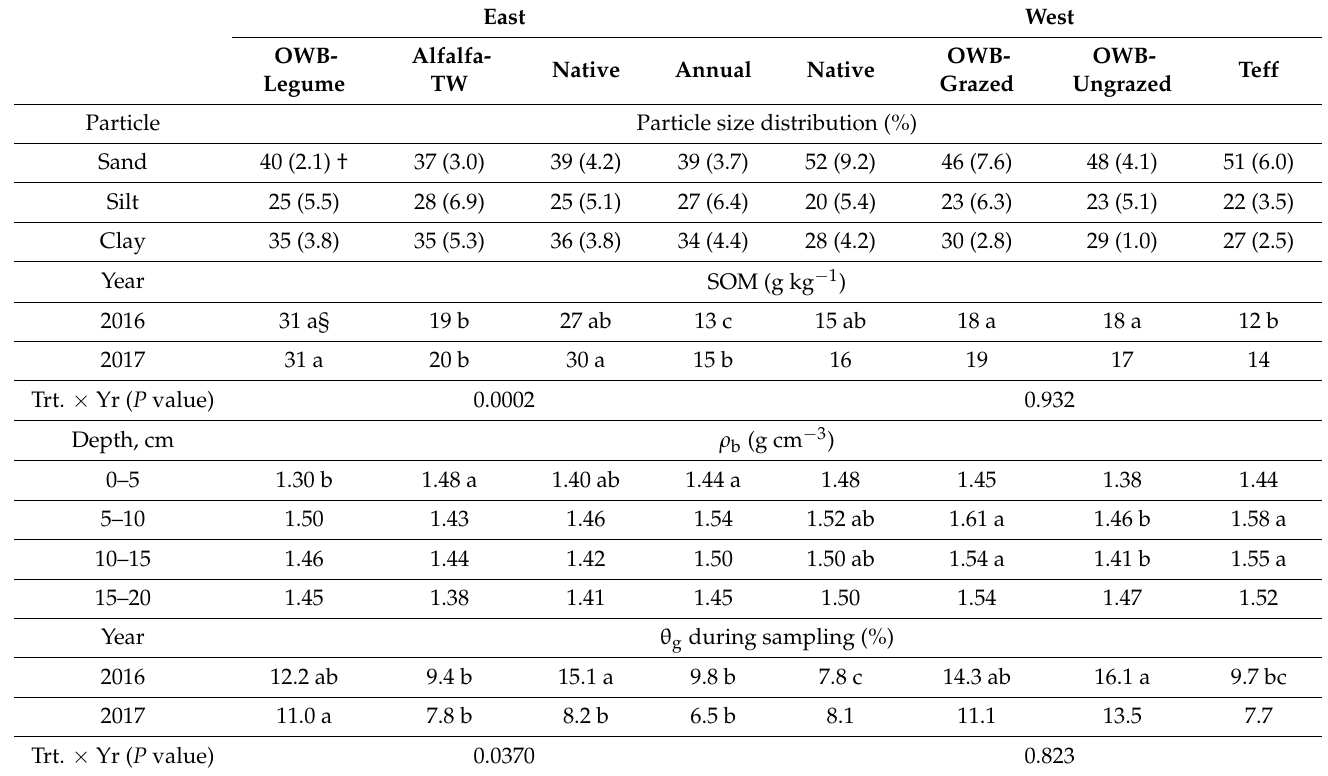
† Numbers in parentheses represent standard deviation. § Means within a row followed by the same lower-case letter are not different at α = 0.05. Abbreviations: Trt., treatment; Yr, year; OWB, Old-World bluestem; TW, tall